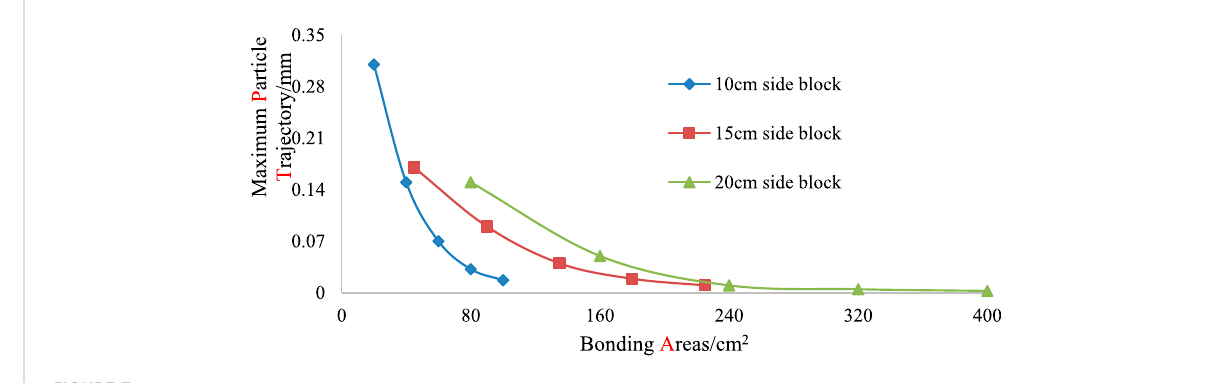
FIGURE 7 Relationship between maximum particle trajectory and bonded area under the same excitation.